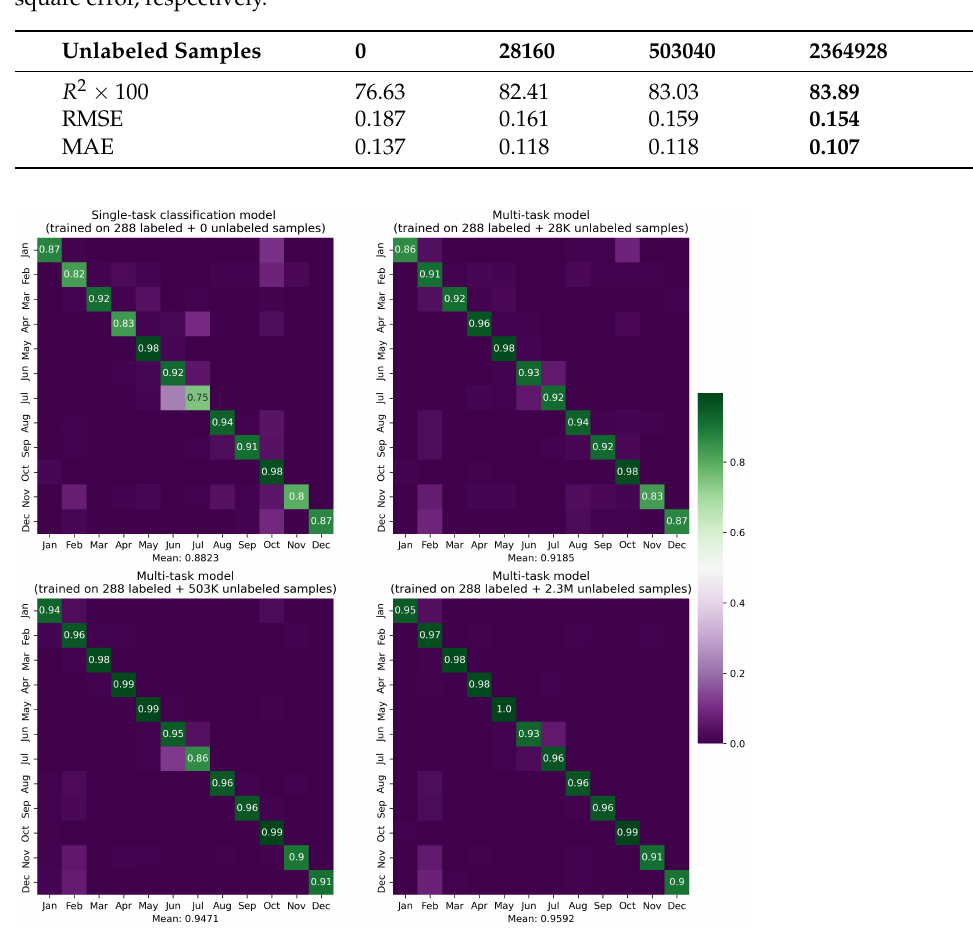
Table 5. Chl-a estimation results of the proposed multitask model across 10-fold cross-validation with different number of unlabeled samples used for its auxiliary task, with the best results in bold, where R 2 , MAE, and RMSE denote coefficient of determination, mean absolute error, and root mean square error, respectively.